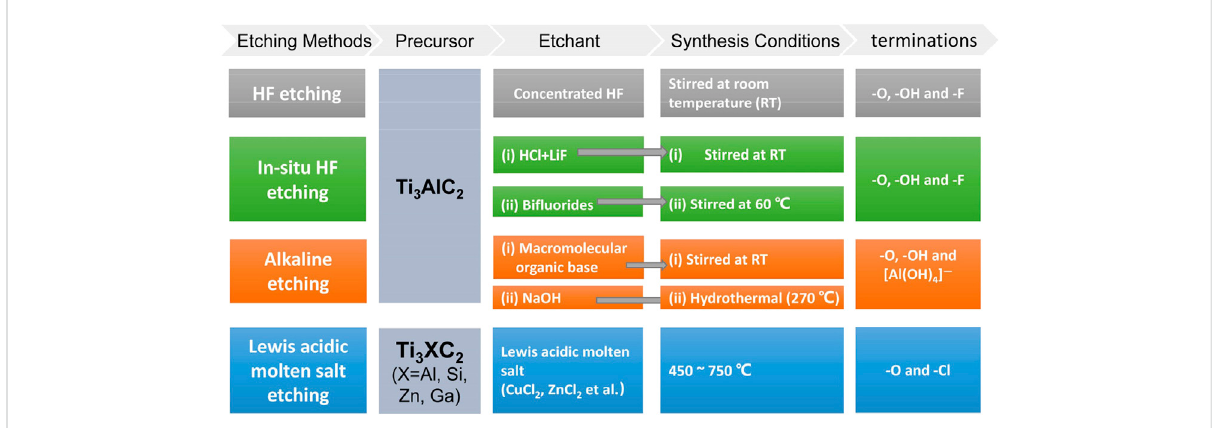
FIGURE 3 Different approaches for the synthesis of titanium carbide MXene (Ti 3 C 2 T x ), Reproduced with permission from Huang et al. (2020), ©American Chemical Society.